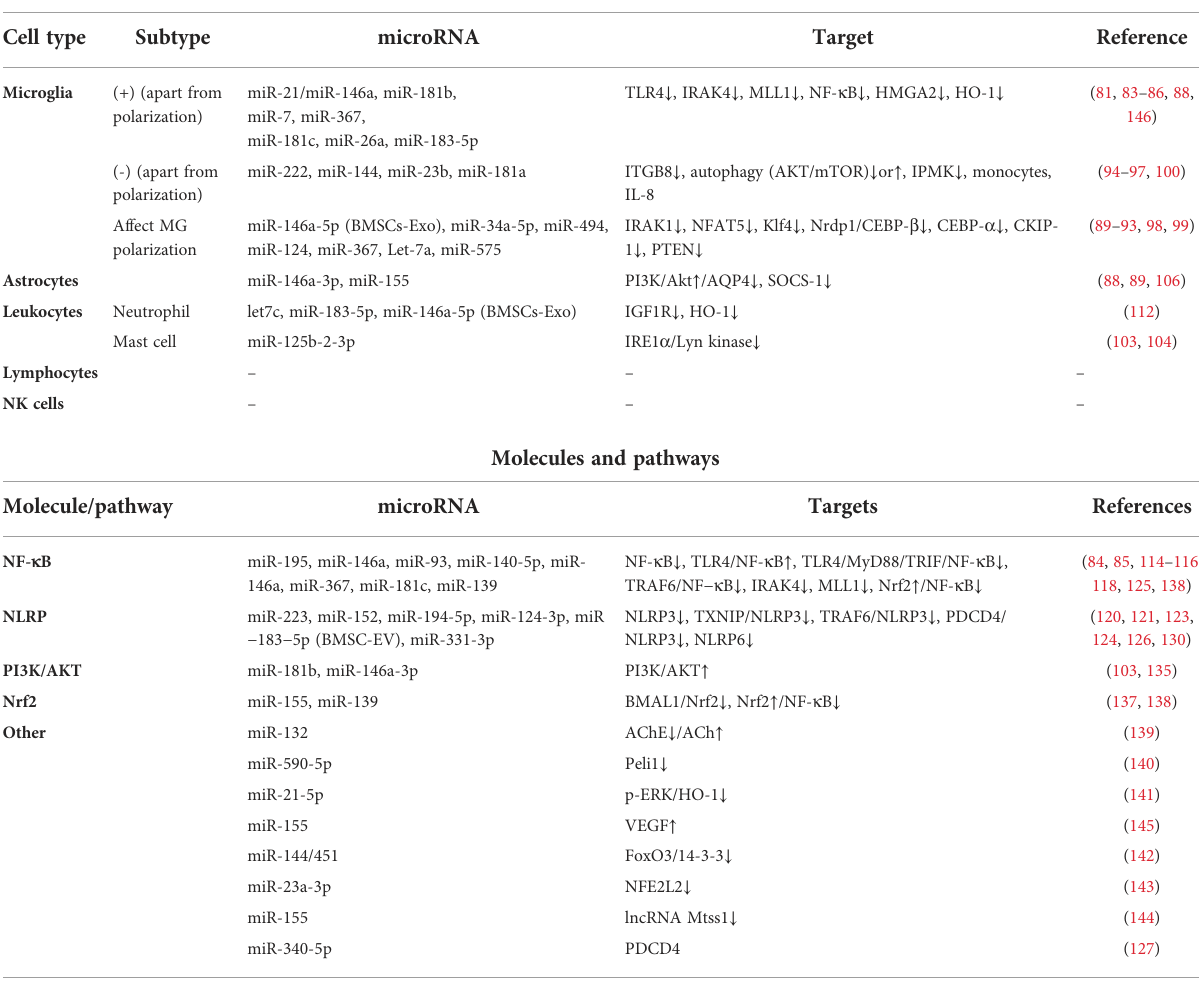
TABLE 1 Effects of microRNAs on immune cells, in fl ammatory molecules, and pathways after